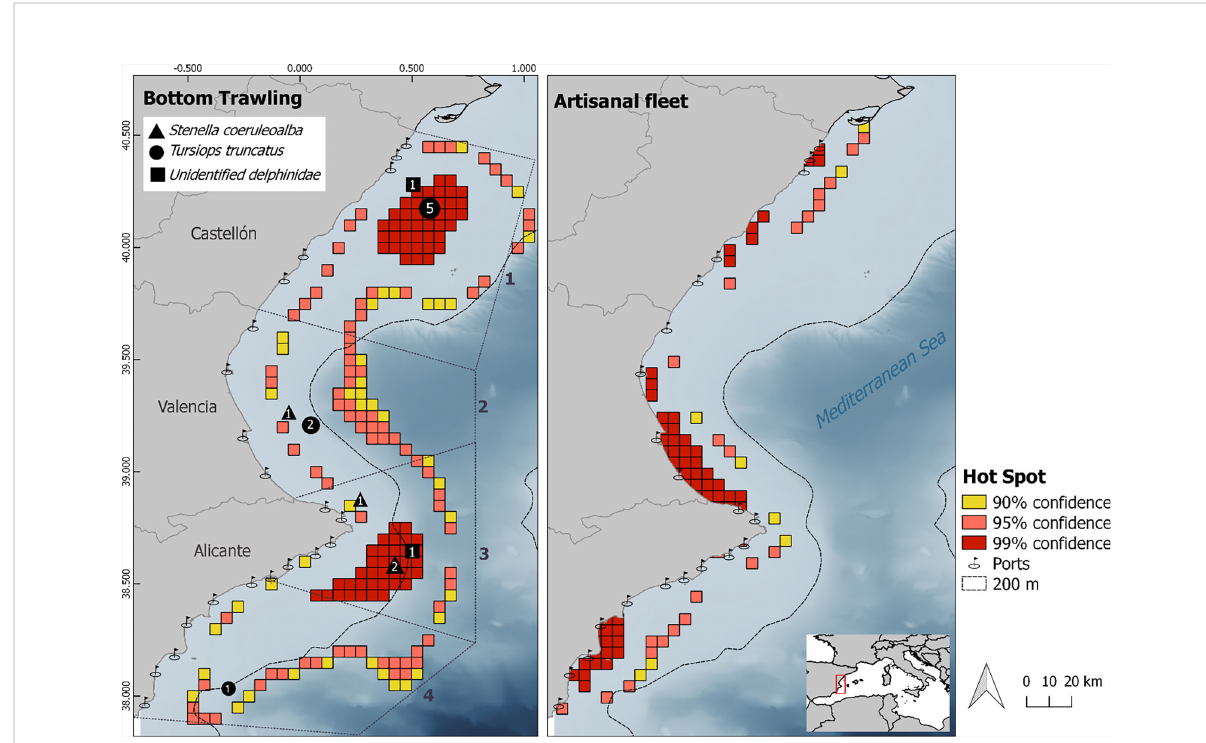
FIGURE 1 Map of the study area (Valencia region, Western Mediterranean) showing the spatial clusters of fi shing activity (hot spots) of bottom trawling (left) and artisanal fl eets (right) during the interview survey period. Cold spots are not represented. The black symbols show the number of delphinid by- catch events reported by the interviewed bottom trawl vessels. The map includes the distribution of 20 surveyed ports in the three provinces. The bathymetry is depicted with darker shades of blue representing deeper waters and dashed light gray line of the 200-m bathymetric contour. The strati fi cation of the study area in the subzones stablished for bottom trawling fi shery is also shown in the map on the